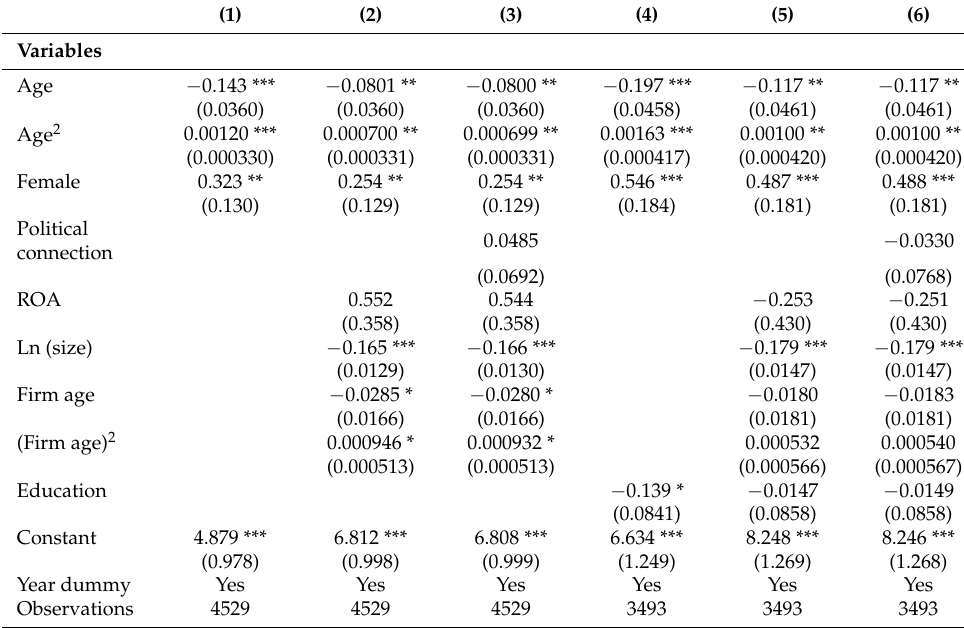
Table 5. Chairperson characteristics and environmental investment